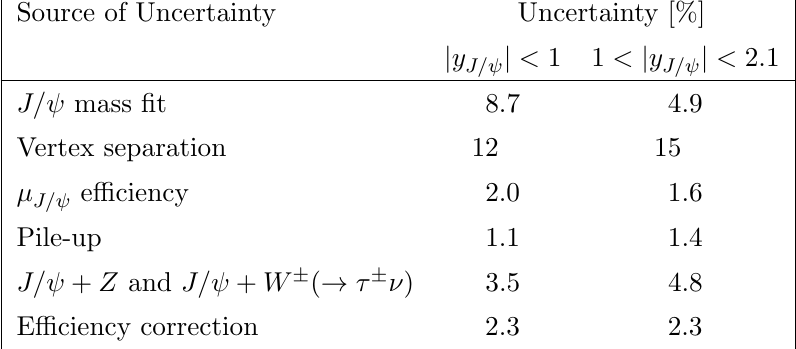
Table 3. Summary of the systematic uncertainties, expressed as a percentage of the measured inclusive cross-section ratio of J= + W (cid:6) to W (cid:6) .